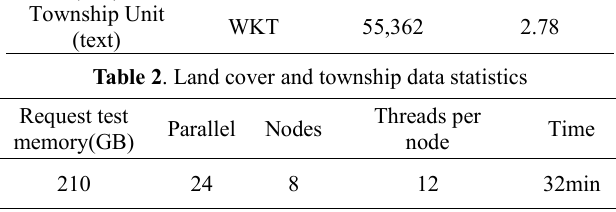
Table 3. Results of land cover intersection of township